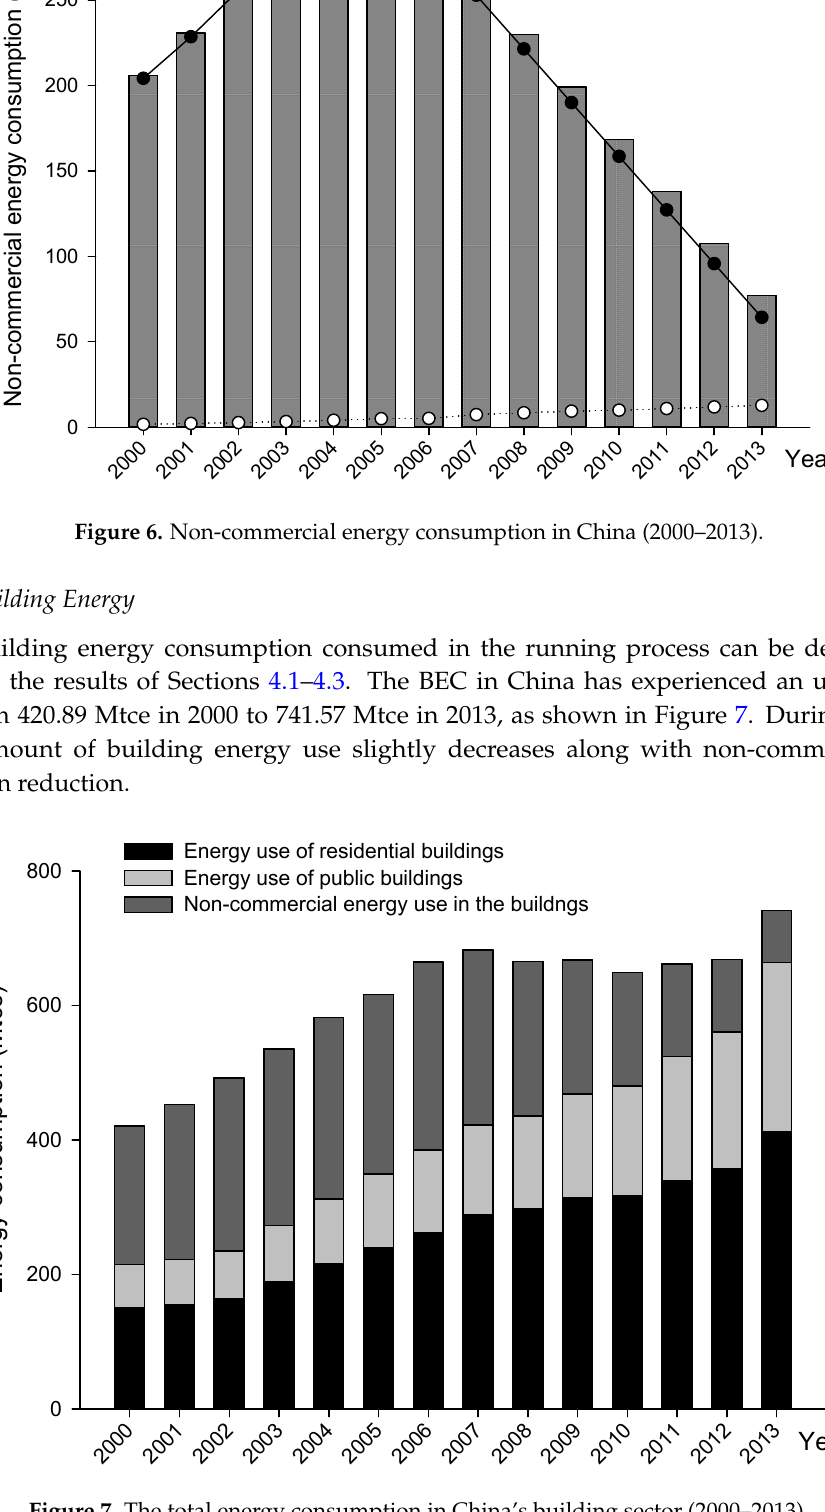
Figure 7. The total energy consumption in China’s building sector